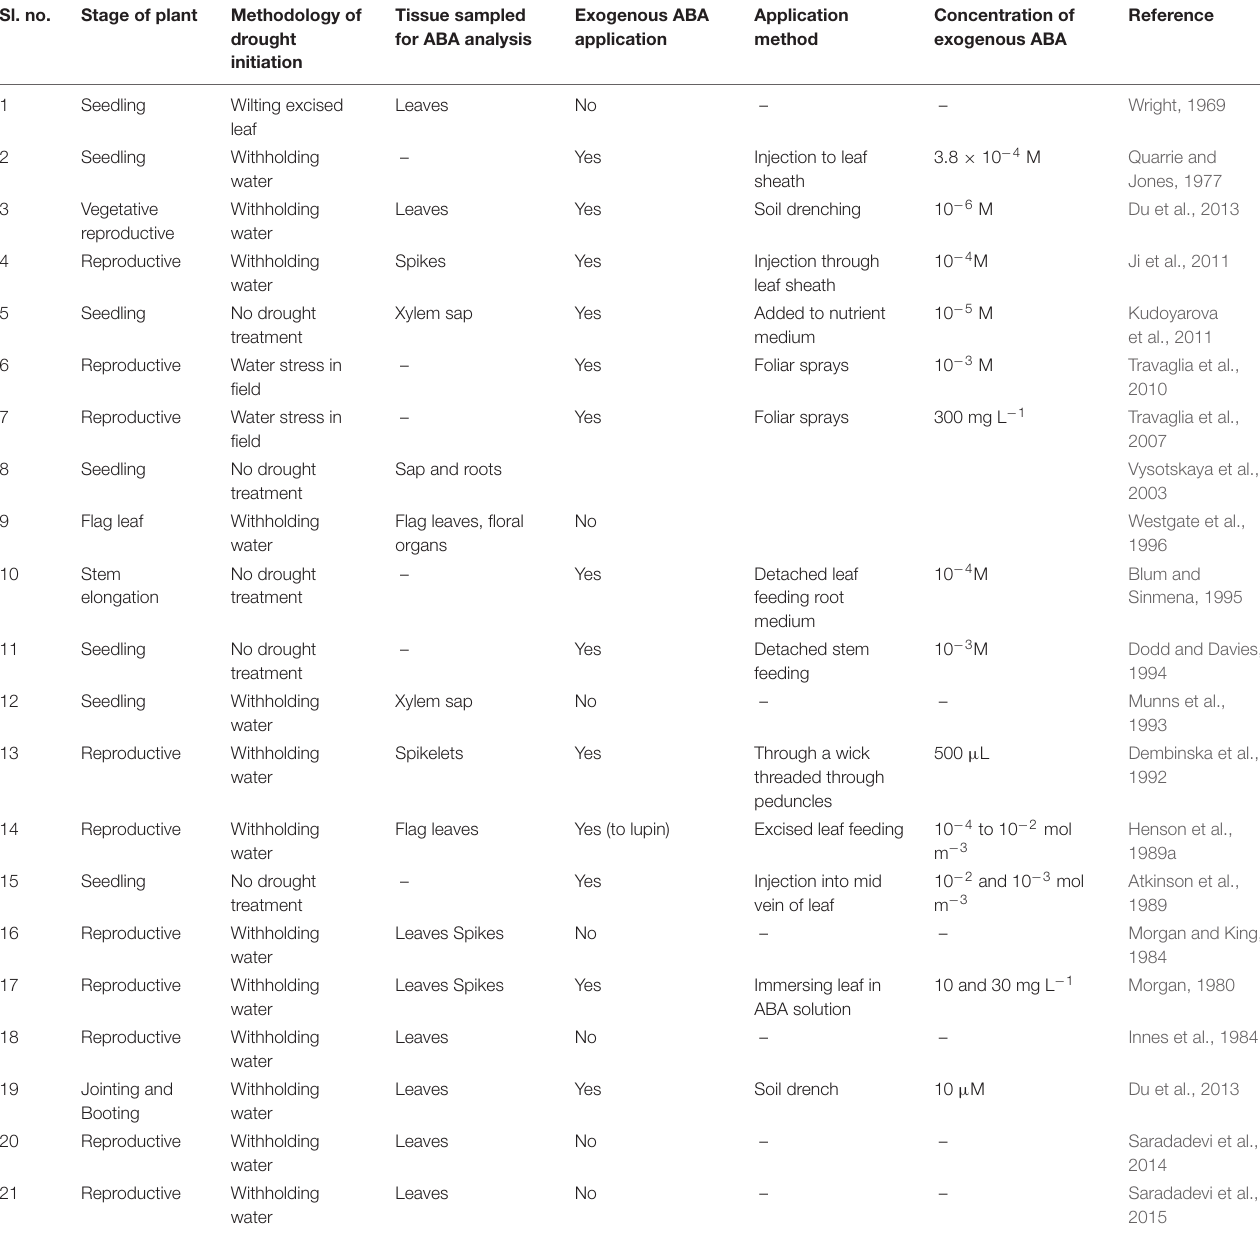
TABLE 1 | Examples of previous research conducted in wheat to elucidate the role of ABA under drought. Sl.